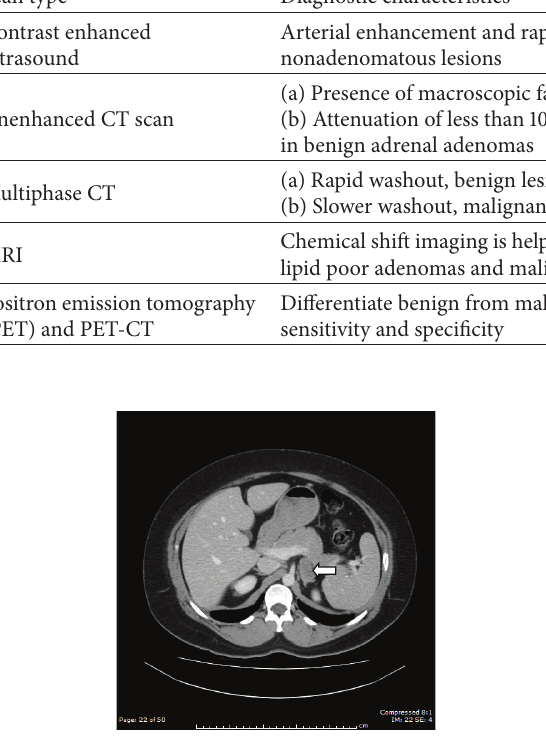
Figure 1: A CT scan of the abdomen showing a well encapsulated “adrenal” mass (solid white arrow).